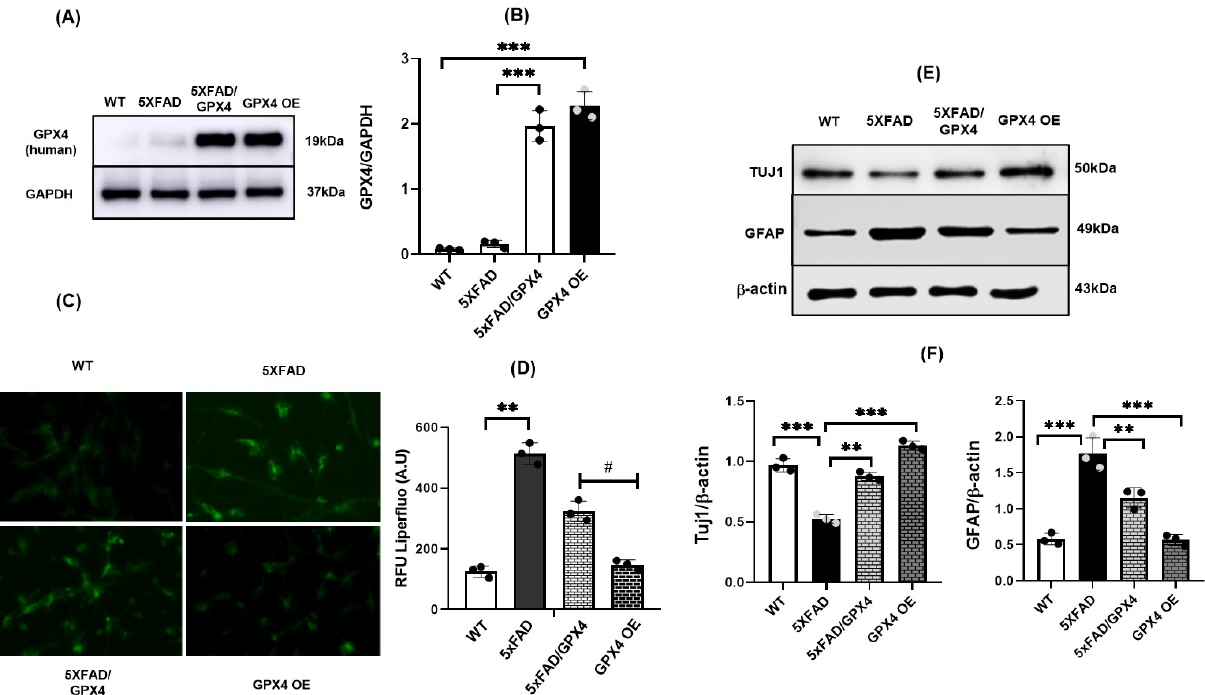
Figure 4. Increased level of neuronal marker protein in differentiated 5×FAD NSCs culture with overexpression of GPX4. ( A , B ) Western blot and densitometric analysis indicate the increased levels of human Gpx4 in 5×FAD/GPX4 and GPX4 OE NSCs. *: p < 0.05. ( C ) Florescence microscopy images representing increased lipid ROS levels in 5×FAD cells and attenuation of these levels with overexpression of GPX4 measured via fluorescence intensity of Liperfluo dye. ( D ). Quantification of Liperfluo relative florescence intensity (arbitrary units) in WT, 5×FAD, 5×FAD/GPX4 and GPX4